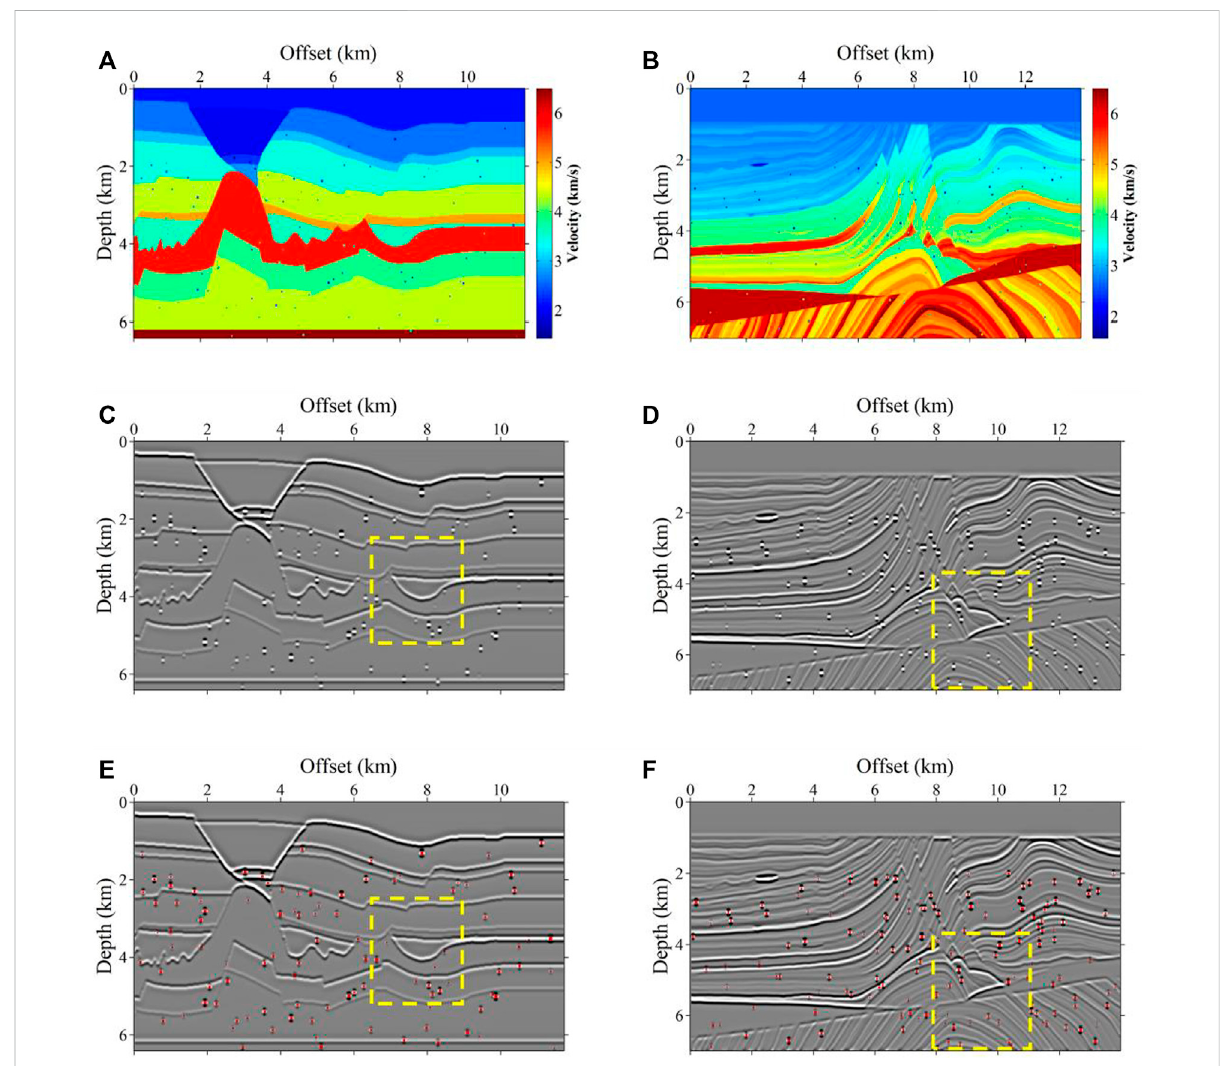
FIGURE 8 Thepredictionresultsonthetestingdataset. (A) ThepartialBP2.5Dmodelwithkarstcaves. (B) TheMarmousimodelwithkarstcaves. (C,D) The corresponding seismic images of (A,B) . (D – F) The overlaid images, consisting of the predicted karst caves of the trained neural network (red spots) and seismic images (C,D)